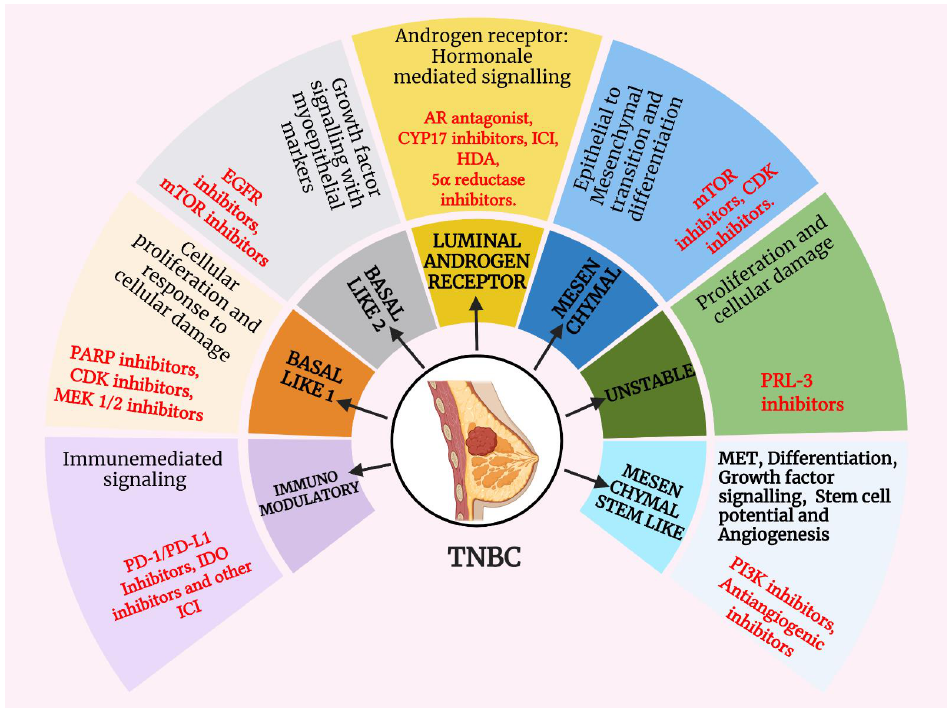
Figure 1. Emphasizing the subtypical elements of TNBC. Programmed cell death 1/programmed cell death ligand 1 (PD1/PD-L1), indoleamine 2,3-dioxygenase (IDO), immune checkpoint inhibitors (ICIs), poly adenosine diphosphate-ribose polymerase (PARP), cyclin-dependent kinase (CDK), mitogen-activated protein kinase (MEK), epidermal growth factor receptor (EGFR), mammalian target of rapamycin (mTOR), androgen receptor (AR), cytochrome P450 (CYP), phosphatase of regenerating liver-3 (PRL-3), phosphatidylinositol 3-kinase (PI3K), mesenchymal epithelial transition (MET).